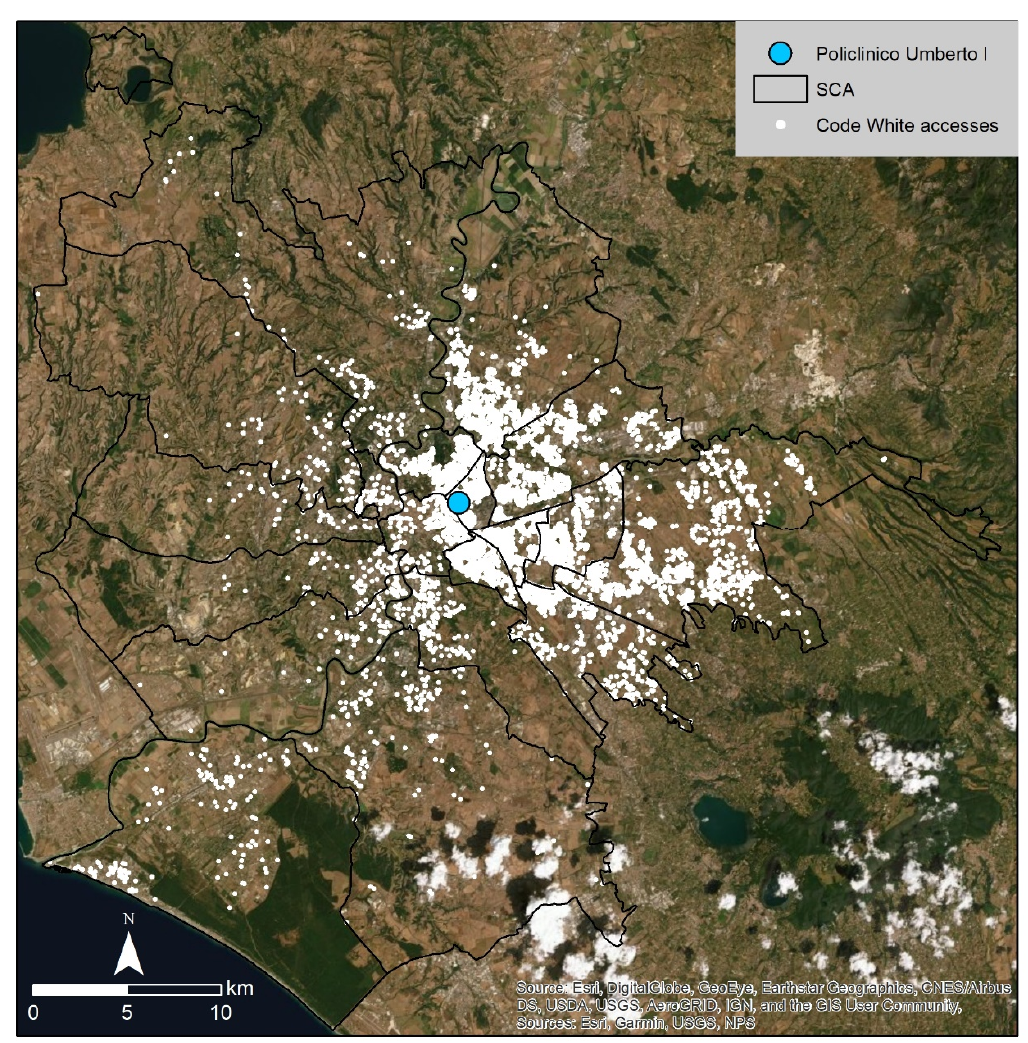
Figure 2. Dot map—elaborated by geocoding—concerning the accesses in code white recorded in 2011 by the Policlinico Umberto I emergency room. Source: authors’ elaboration.